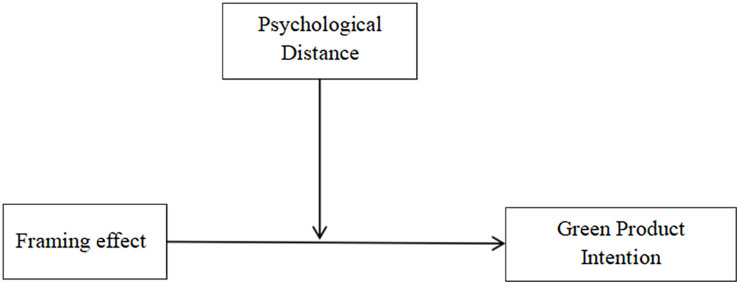
Model of Study 1.